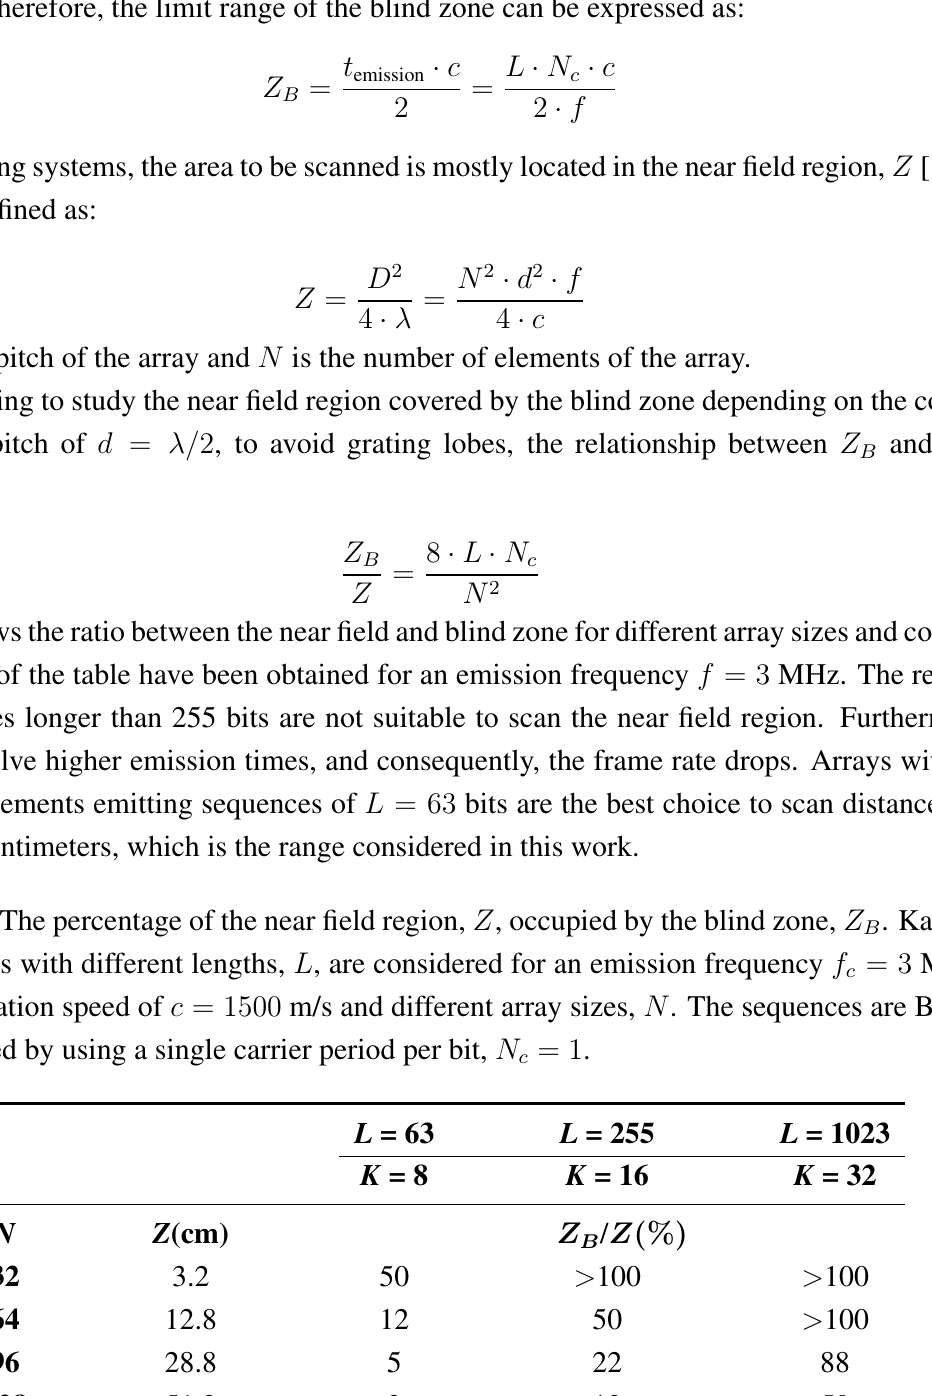
Table 1. The percentage of the near field region, Z , occupied by the blind zone, Z sequences with different lengths, L , are considered for an emission frequency f a propagation speed of c = 1500 m/s and different array sizes, N . The sequences are BPSK modulated by using a single carrier period per bit, N